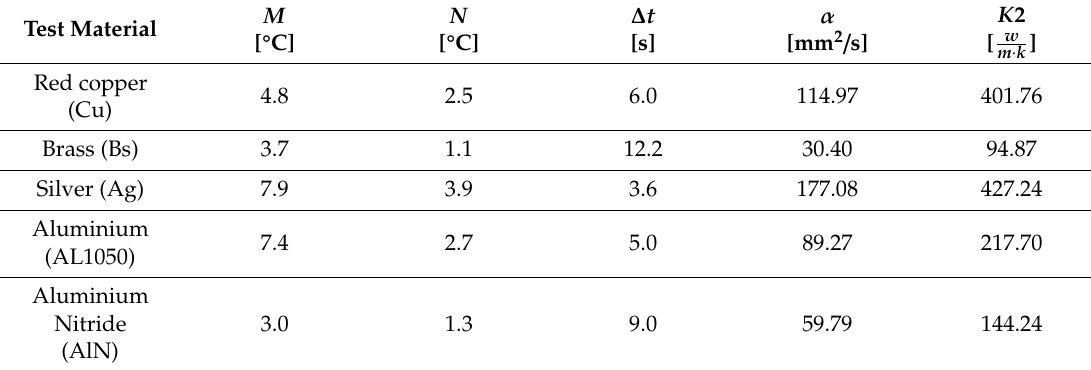
Table 2. Sample measurement results.